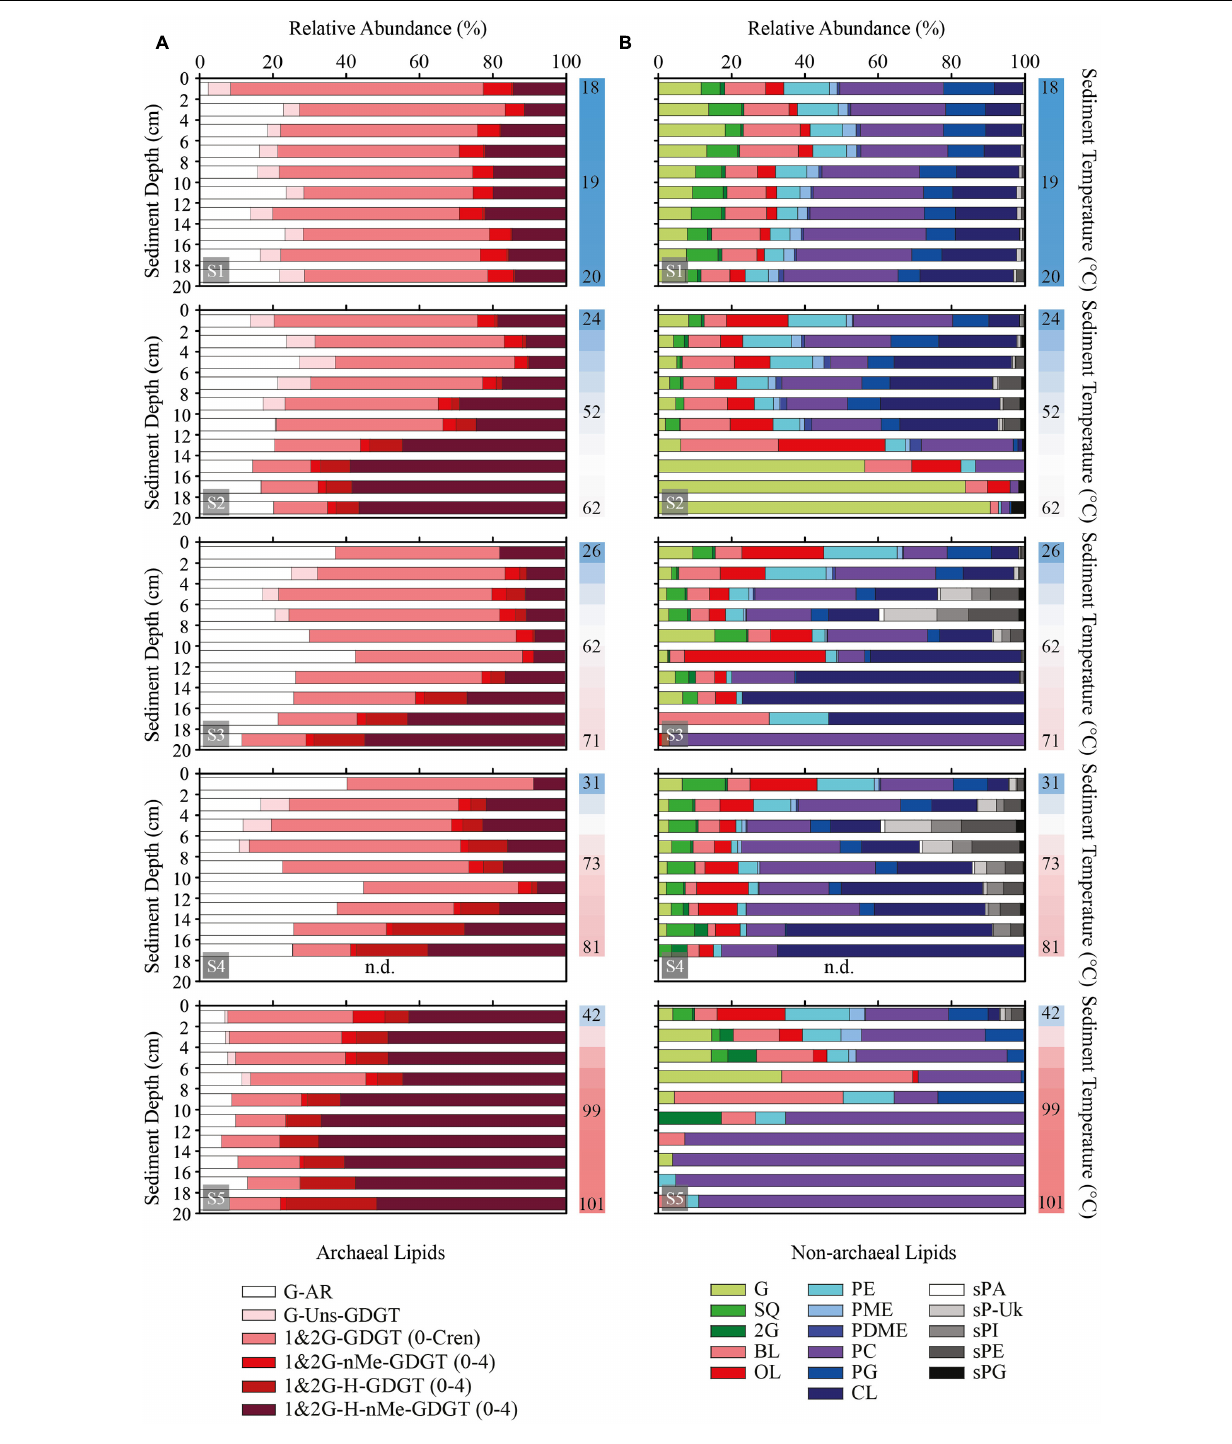
FIGURE 3 | Sediment profiles displaying the abundance of polar lipid classes relative to total archaeal (A) and total non-archaeal (B) lipids. Note that this figure should be interpreted together with the relative abundance of archaeal and bacterial polar lipids shown in Figure 2 . Samples were analyzed in 2 cm horizons from surface until 20 cm of sediment depth. Adjacent vertical bars indicate the thermal gradient of each station with upper, mid and bottom sediments temperatures in ◦ C. n.d., no data. Abbreviations: monoglycosidic archaeol (AR); monoglycosidic unsaturated (Uns) acyclic glycerol-dibiphytanyl-glycerol-tetraethers (GDGT); mono- and diglycosidic GDGT with 0 to 5 rings (0-Cren); mono- and di-glycosidic GDGT with up to 4 rings divided into mono- and di-methylated (nMe), H-shaped (H) and H-nMe-GDGT with up to 4 methyl groups. Cren, crenarchaeol. For abbreviations of non-archaeal lipid classes please see Main Text. sP-Uk, unknown glycosylated phosphatidyl